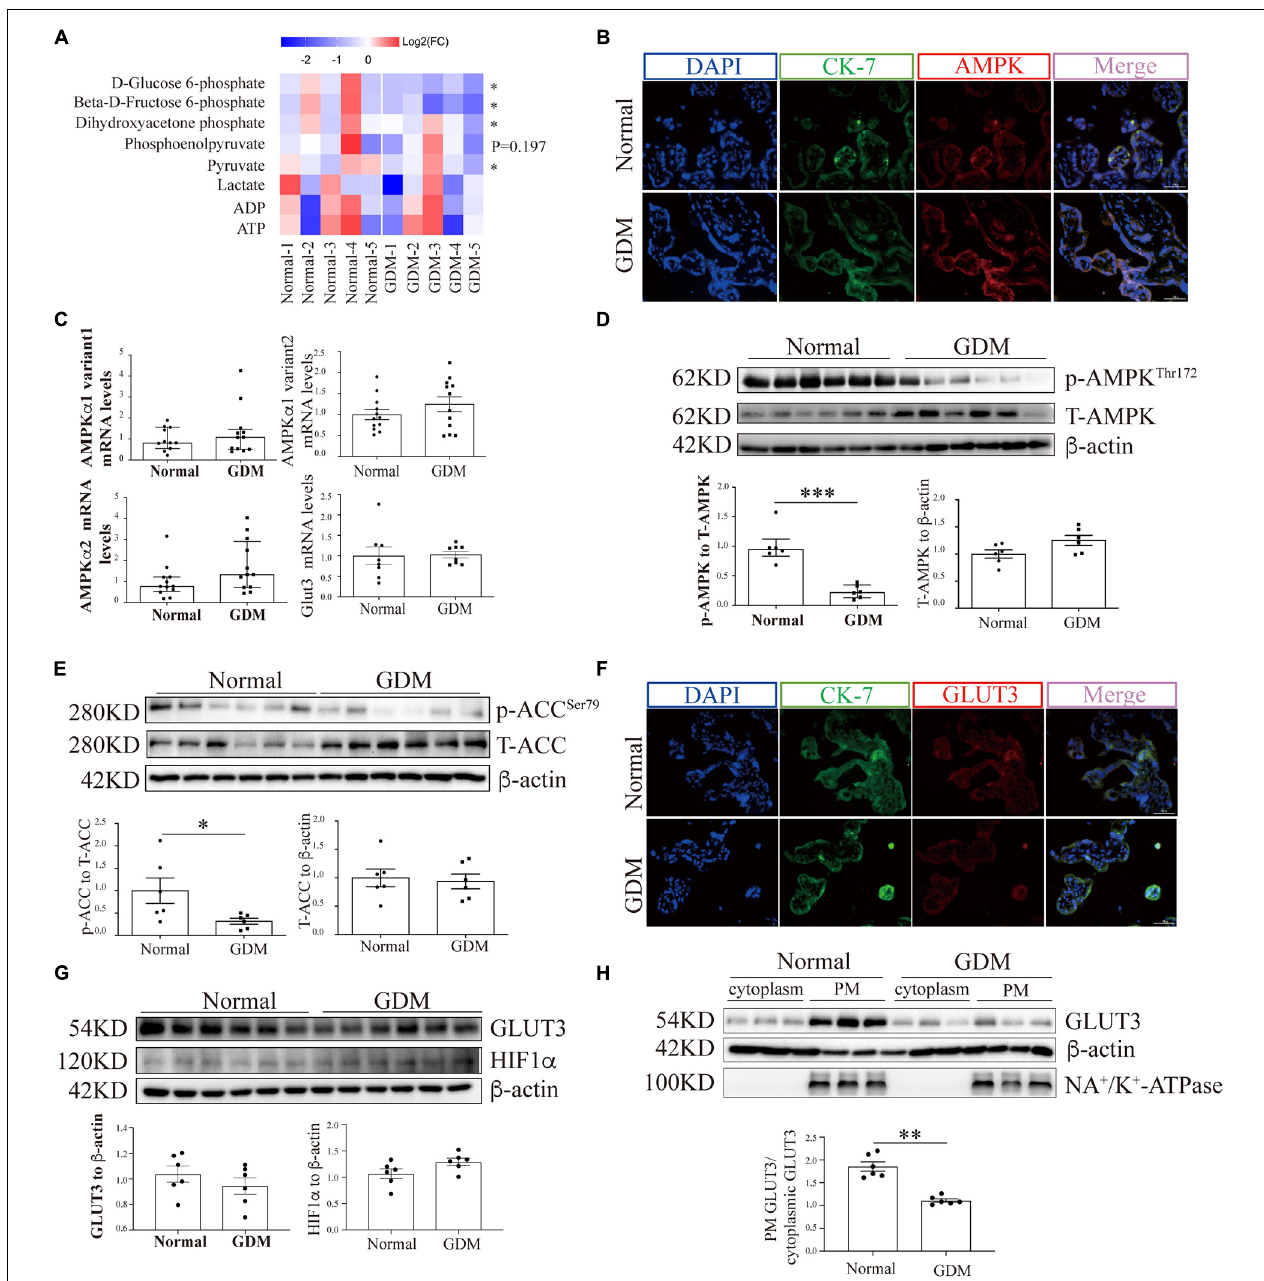
FIGURE 1 | AMP-activated protein kinase signaling and the membrane-bound GLUT3 levels are compromised in GDM-complicated human placentas. (A) Heatmaps showing the relative intracellular levels of glycolytic intermediates in normal and GDM-complicated placentas. The fold change (FC) represents the ratio of the ion intensity of each compound in each sample to the average ion intensity of the compound in the normal group, and Log2(FC) values were then calculated and are presented in the heatmap. The color indicates the abundance of representative compounds, and the color key is shown at the top of the figure. Student’s t -test was used for the analysis; n = 5. (B) IF staining of AMPK in normal and GDM-complicated human placentas. Extravillous trophoblast cells were stained with CK-7, and nuclei were counterstained with DAPI. Bar: 50 µ m. (C) mRNA levels of AMPK α and GLUT3 in GDM-complicated and control human placentas; n = 8–12/group. (D) p-AMPK and AMPK levels in placental tissue from the GDM and control groups. β -Actin was used as a loading control; n = 6. (E) p-ACC and ACC levels in GDM-complicated and control placentas. β -Actin was used as a loading control; n = 6. (F) IF staining of GLUT3 in normal and GDM-complicated human placentas. Extravillous trophoblast cells were stained with cytokeratin 7 (CK-7), and nuclei were counterstained with DAPI. Bar: 50 µ m. (G) GLUT3 and HIF-1 α protein levels in GDM-complicated and normal placentas; n = 6. (H) Levels of PM-bound GLUT3 protein in GDM-complicated and normal placentas. n = 6; PM GLUT3: PM GLUT3 expression/Na + -K + -ATPase expression; cytoplasmic GLUT3: cytoplasmic GLUT3 expression/actin expression. The data that are presented as the means ± SEMs are annotated in normal font, and Student’s t -test was used between two groups. The data presented as the medians (IQRs) are shown in bold font and Mann-Whitney test was used between two groups. ∗ p < 0.05, ∗∗ p < 0.01, and ∗∗∗ p < 0.001.